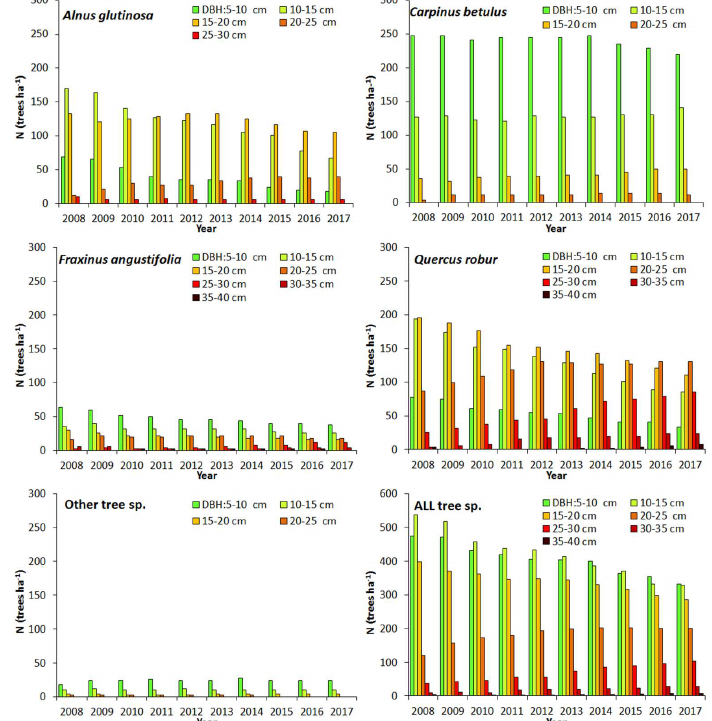
Figure A5. Cumulative fluxes ( NEE , GPP , R ECO and NPP ; panels A – D , respectively) estimated with EC during the period of the study.